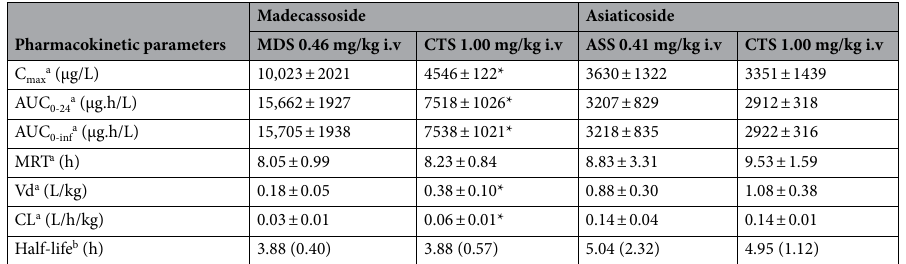
Table 1. Pharmacokinetic parameters of madecassoside and asiaticoside after intravenous administration of 0.46 mg/kg madecassoside, 0.41 mg/kg asiaticoside, or 1.00 mg/kg Centell-S. C max maximum plasma concentration, AUC 0-24 area under the plasma concentration–time curve from time 0–24 h, AUC 0-inf area under the plasma concentration–time curve from time 0-infinity, MRT mean residence time, Vd volume of distribution, CL clearance, MDS madecassoside, ASS asiaticoside, CTS Centell-S. a Data are expressed as mean ± SD; b Data are expressed as median (IQR); * p < 0.05 for significant differences.